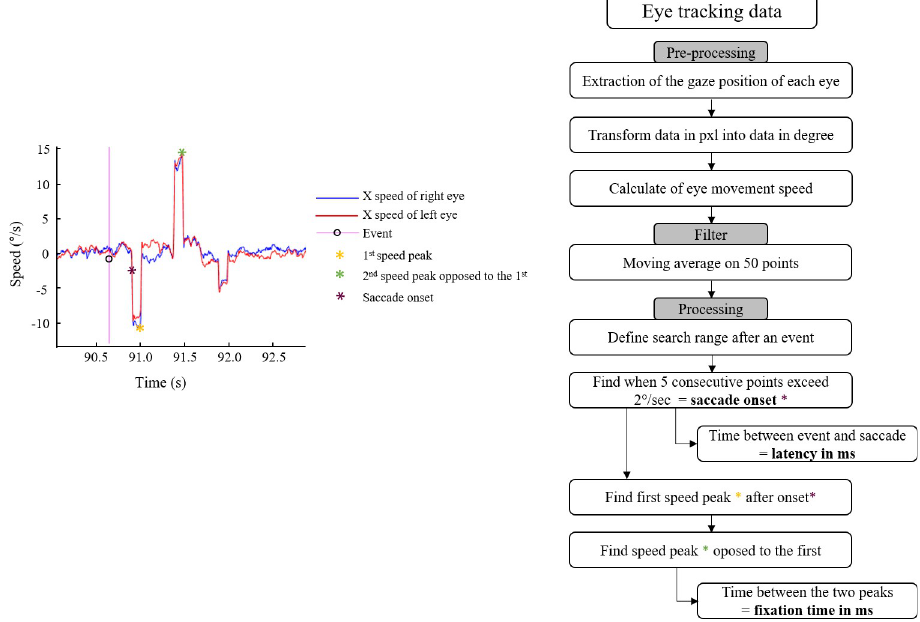
Fig 9. Eye tracking data for a single participant for one event and the analysis